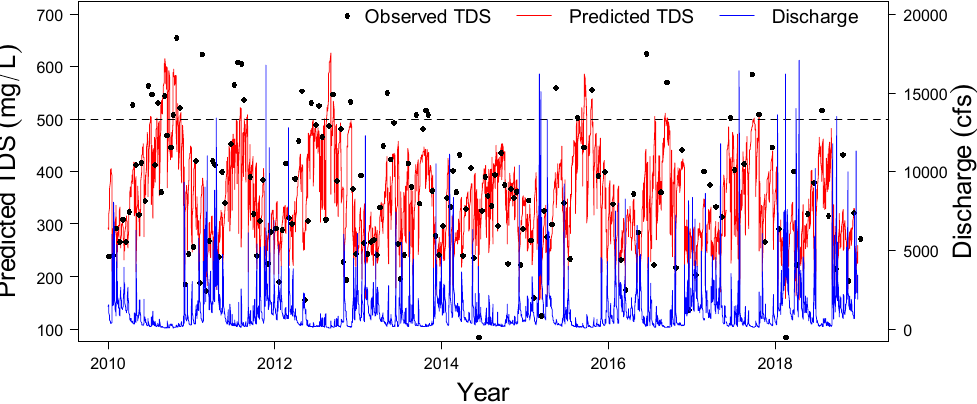
Figure 4. Time series of predicted TDS and observed discharge at the West Fork water quality and United States Geological Survey (USGS) gauge station (refer to Figure 1 for locations). Observed TDS is shown for reference.